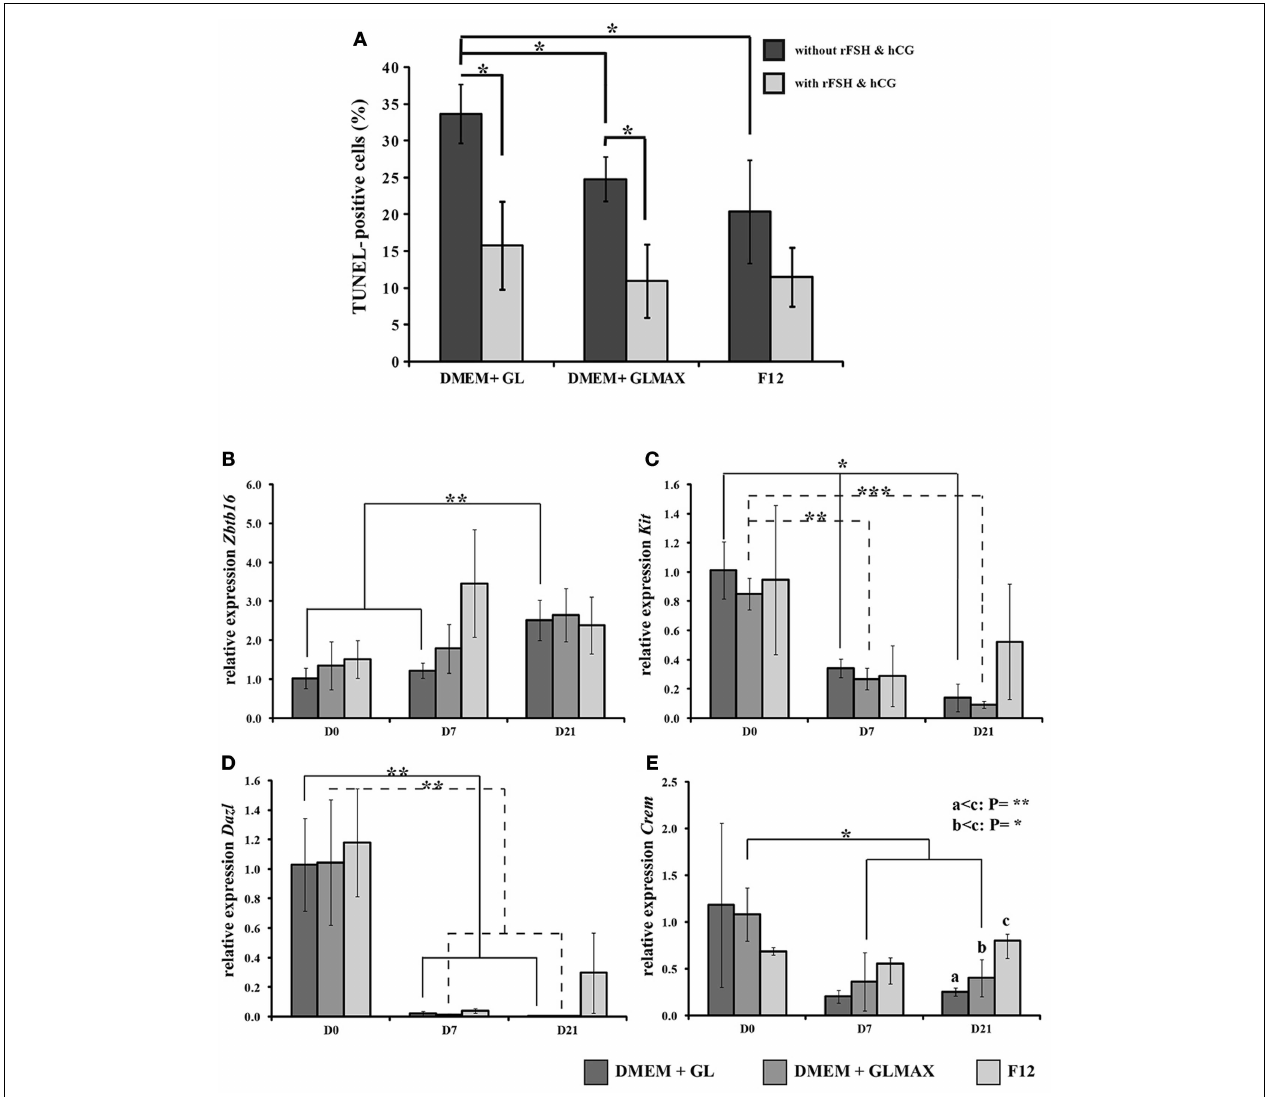
relative expression of rat Zbtb16 (also known as Plzf ) (B) , Kit (C) , Dazl (D) , and Crem (E) (determined by qPCR analysis with Actb as an internal control) by cells cultured in DMEM + glutamine (DMEM + GL), DMEM + Glutamax (DMEM + GLMAX), or F12. On the X -axis, the different periods of culture [0 (D0), 7 (D7), and 21 (D21) days] are depicted and the Y -axis shows the mean relative expression of replicates calculated by the ddCt procedure. Student’s t -test was applied to compare the different experimental conditions. * p < 0.05, ** p < 0.01, *** p <